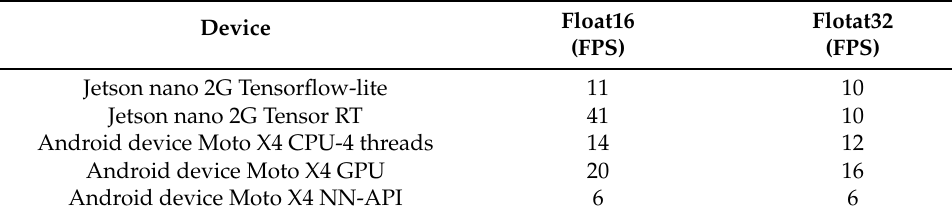
Table 6. Frames per second on embedded